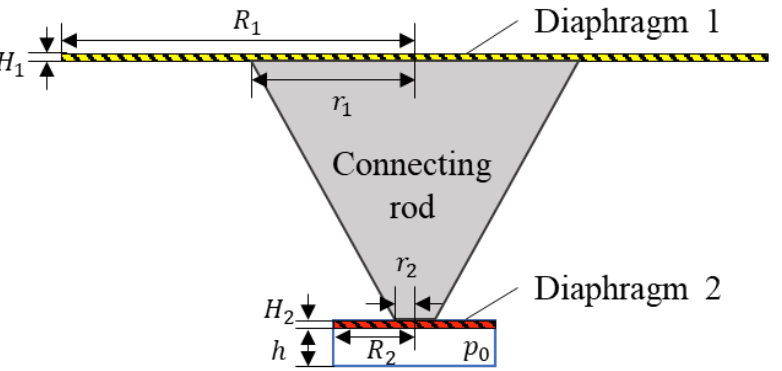
Figure 2. An equivalent schematic diagram of the force model for the presented SPAS.